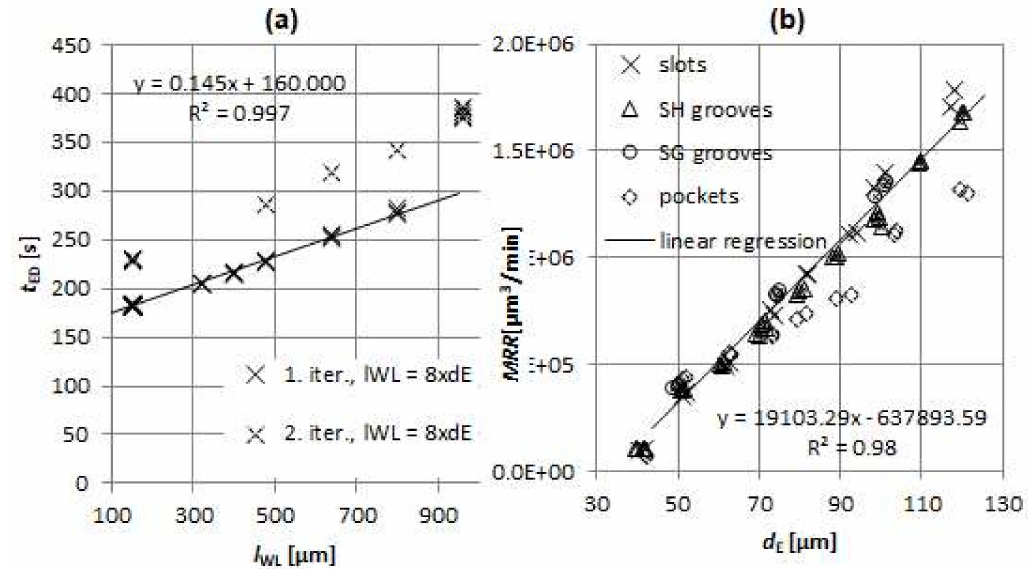
Figure 9. ( a ) Electrode dressing times t ED for various electrode working lengths ( l WL = 8 × d E ). Linear regression was applied to the data set, where the electrodes are dressed in the first iteration. ( b ) Material removal rate ( MRR ) with respect to electrode diameter d E . For the linear regression, only slotting experiments (slots, SH and SG grooves) were